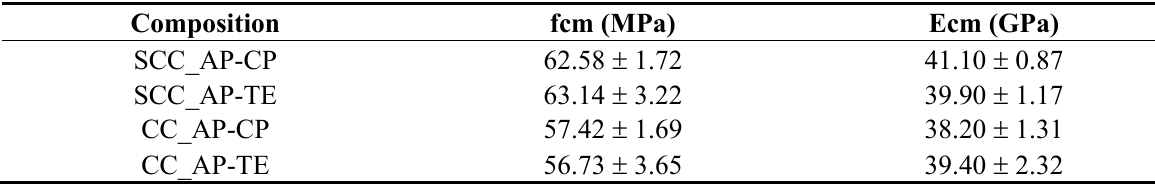
Table 5. Compressive strength (f cm ) and modulus of elasticity (E cm ) for the Pernambuco Arena.